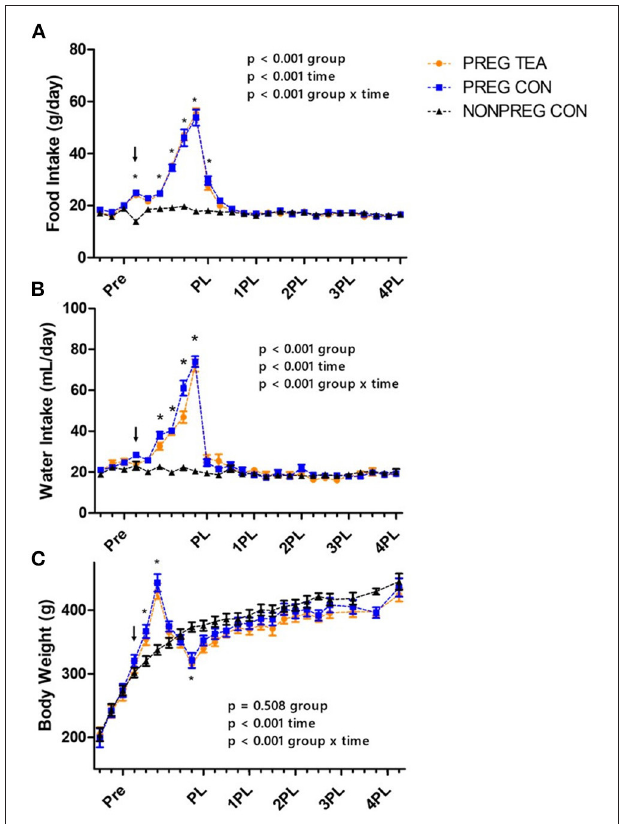
FIGURE 2 | Group daily food and water intake and average body weights; (A) mean daily food intake, (B) mean daily water intake, and (C) body weight of female Sprague-Dawley Values are mean ± SEM, n = 13 (PREG CON) or 14/group (PREG TEA and NONPREG CON). Significant differences ( p < 0.05) between pregnancy and lactation groups (PREG TEA and PREG CON) and NONPREG CON within a time point are denoted by *. The arrow above data points represents the onset of pregnancy. Pre, pre-pregnancy; PL, post-lactation; 1PL, 1 month post-lactation; 2PL, 2 months post-lactation; 3PL, 3 months post-lactation; and 4PL, 4 months post-lactation.